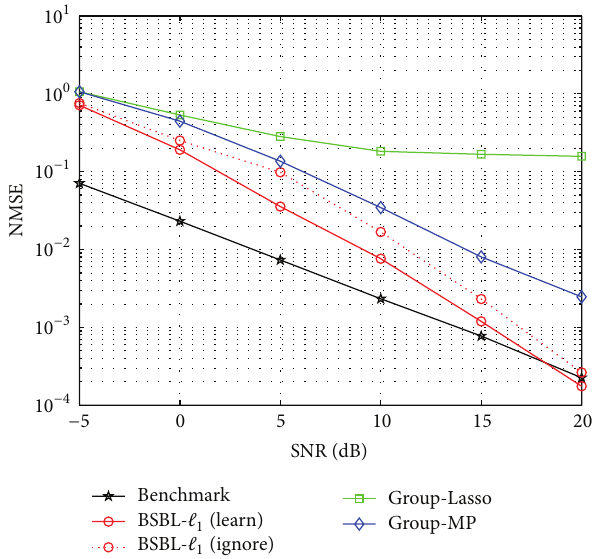
Figure 2: Comparison of NMSE versus SNR. Grid distance is 10